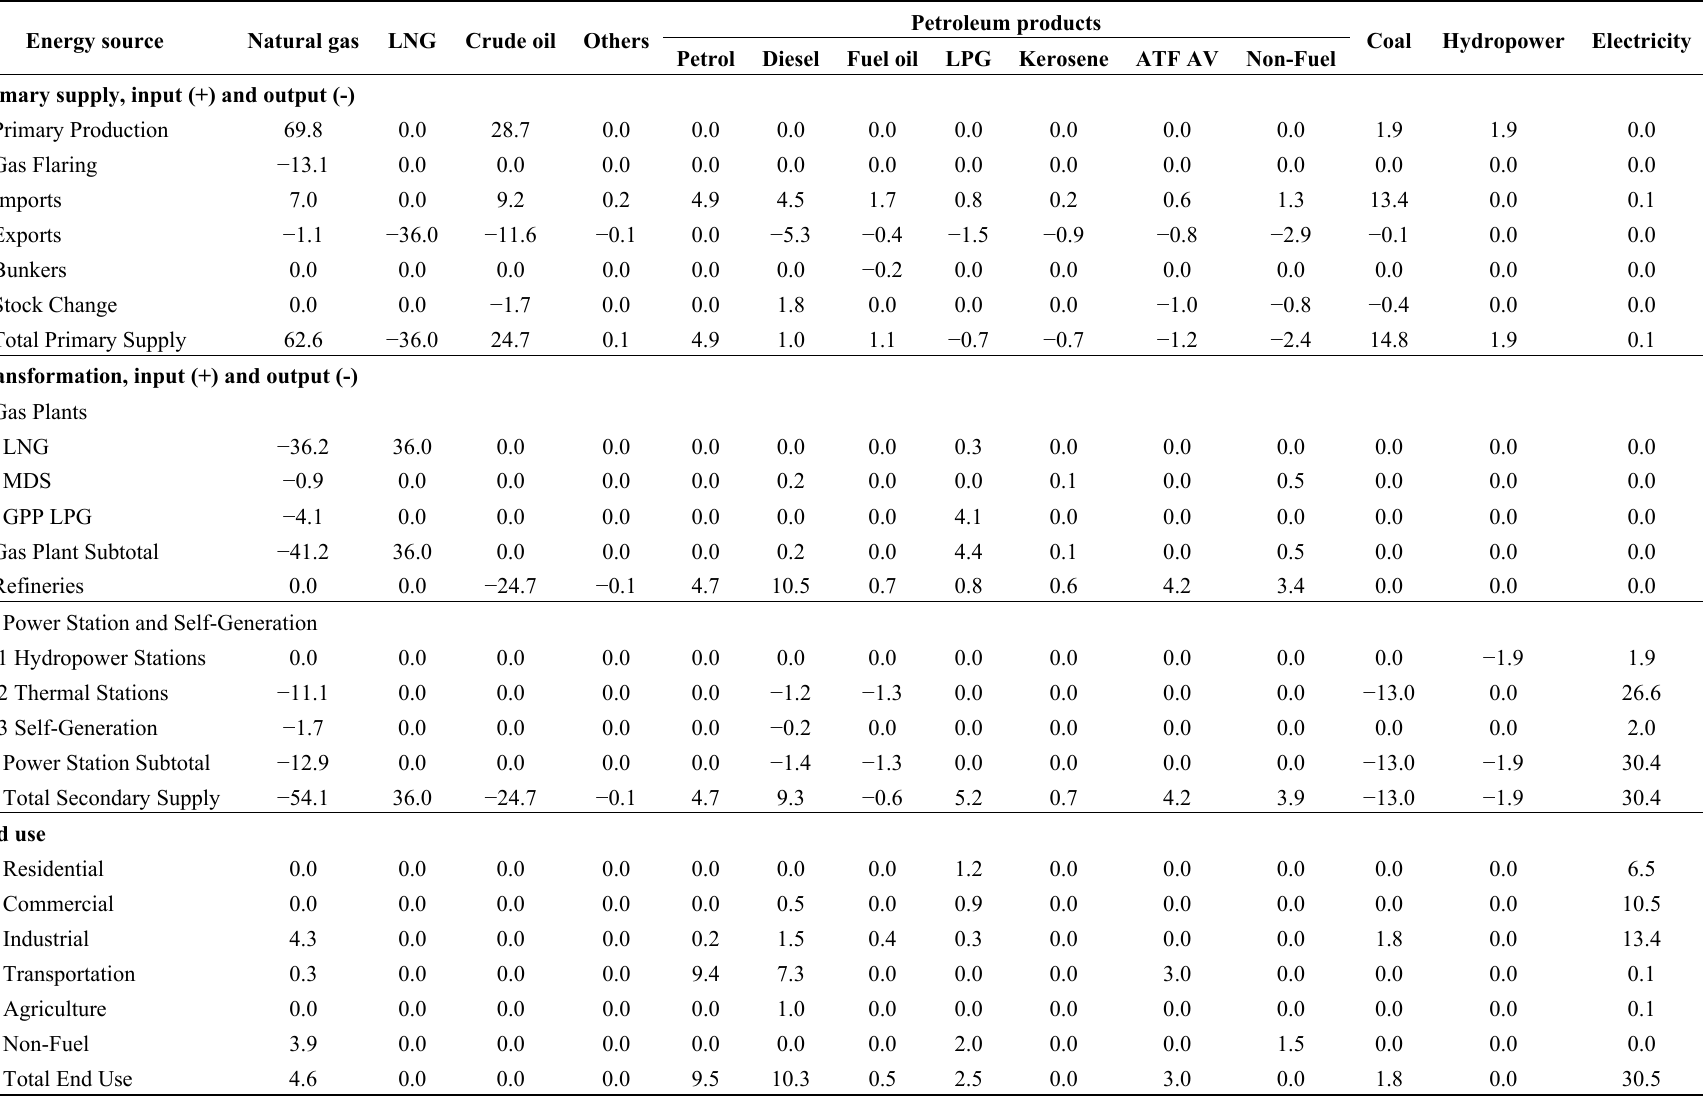
Table 5. Input data for mapping energy allocation diagram of Malaysia